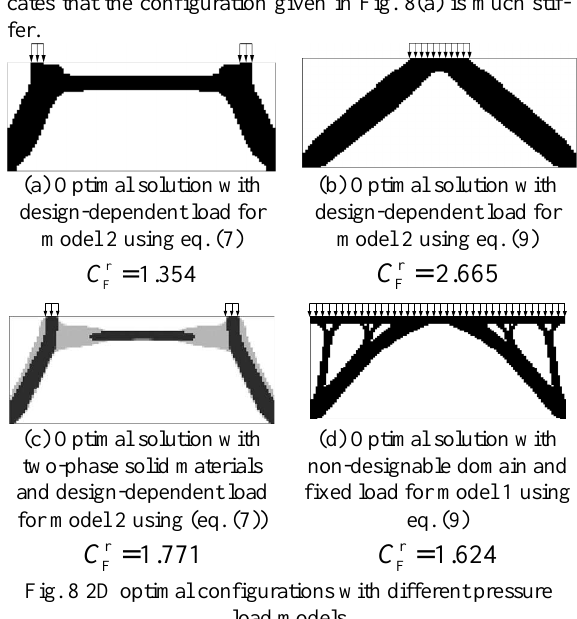
Fig. 8 2D optimal configurations with different